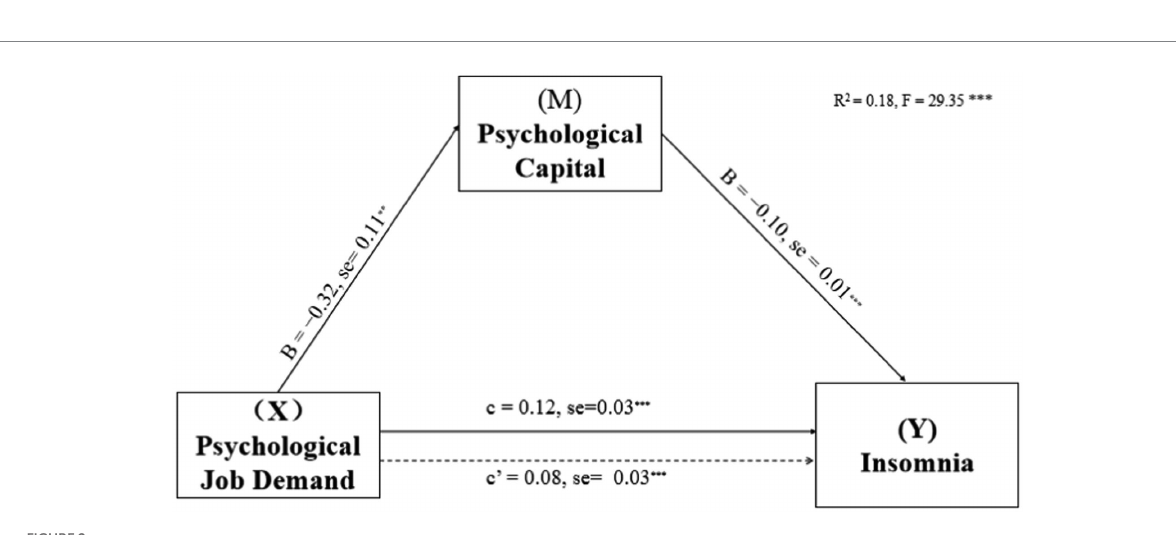
FIGURE 2 Mediation of Psychological capital in the relationship between psychological job demand and insomnia symptoms with non-standardized beta values and standard error. ** p < 0.01, *** p <